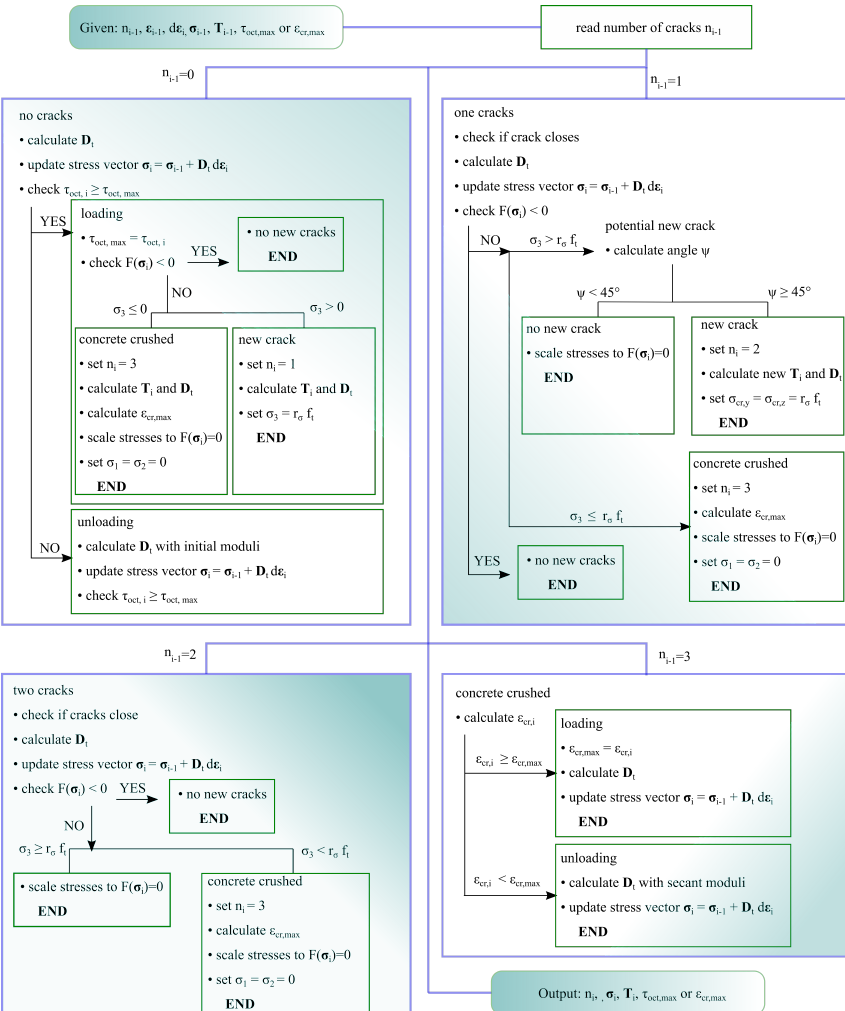
Figure 8. Flowchart with the implemented algorithm for the material model of concrete. Subscript i − 1 represents the value for the previous iteration, while i value for the present